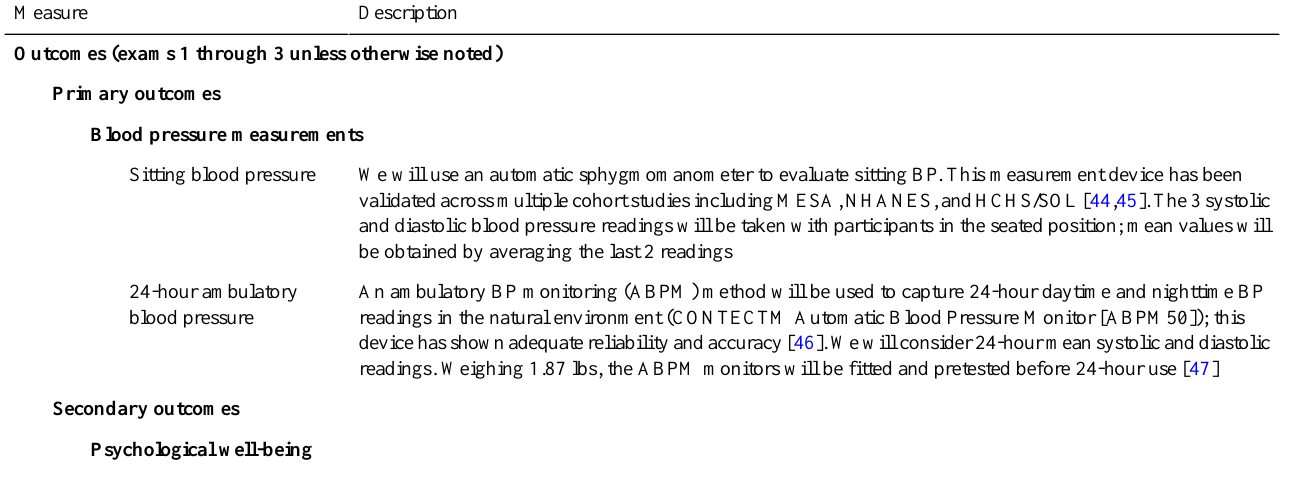
Table 2. Outcome, mediator, and intervention-based measures.